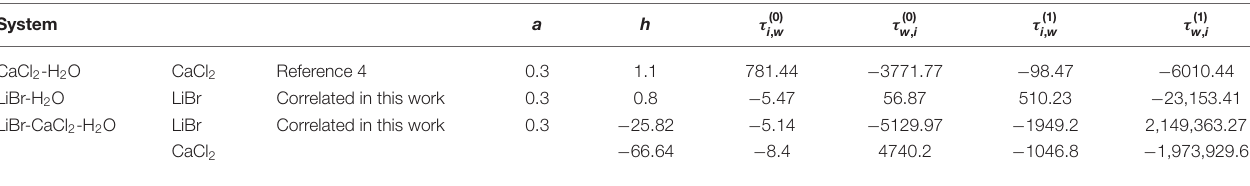
TABLE 7 | Model parameters for the CaCl 2 -H 2 O, LiBr-H 2 O, and LiBr-CaCl 2 -H 2 O systems.